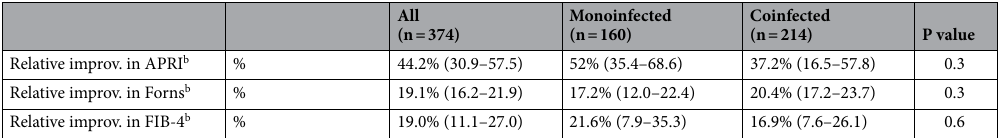
Table 1. Demographic, HCV-related, laboratory and NILFM parameters in mono- and coinfected patients. Values are expressed as mean (95% CI) or % as appropriate. DAA denotes direct acting antivirals, HCV hepatitis C virus, HIV human immunodeficiency virus, HDL high density lipoproteins, INR international normalized ratio, LDL low density lipoproteins, NILFM non-invasive liver fibrosis markers, TE transient elastometry. a Difference and b ratio between 24-month and baseline intrasubject measurements.